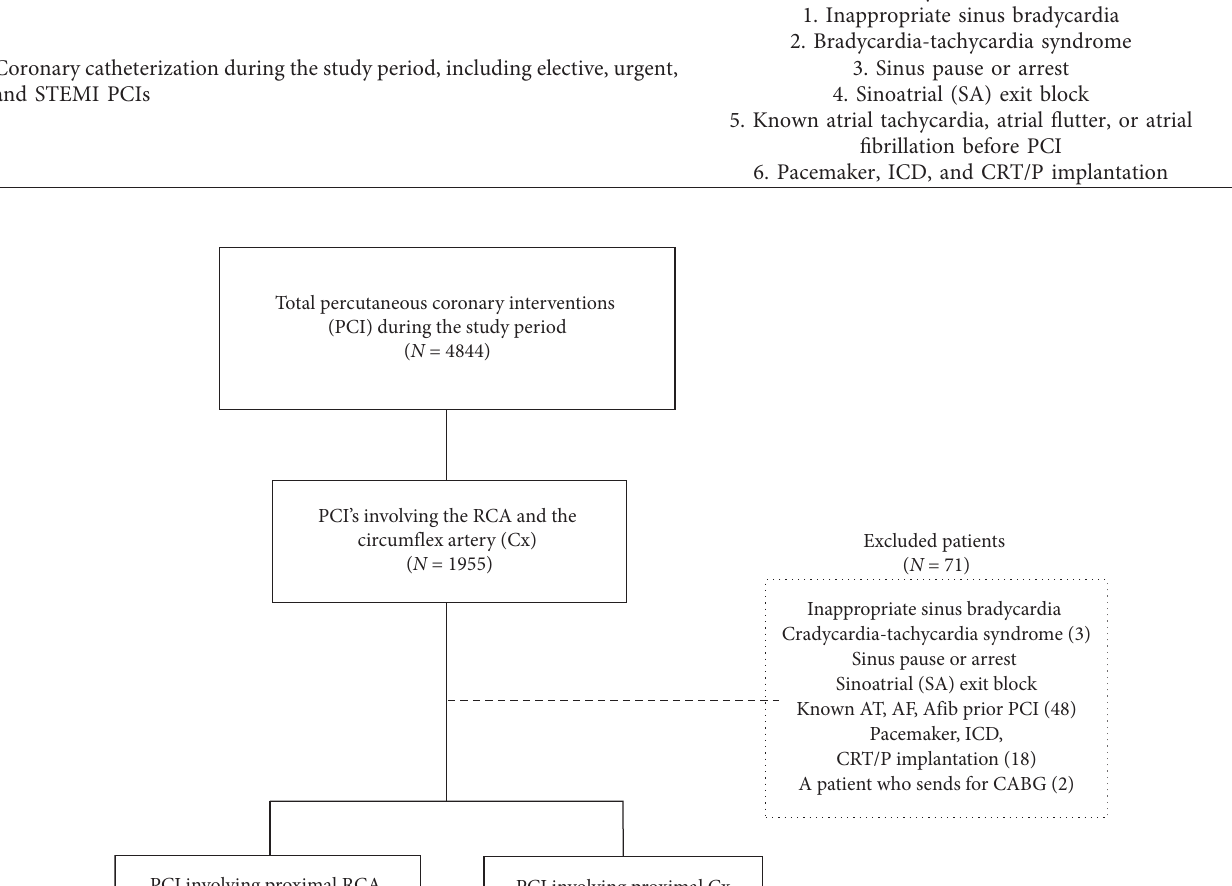
Coronary catheterization during the study period, including elective, urgent, and STEMI PCIs